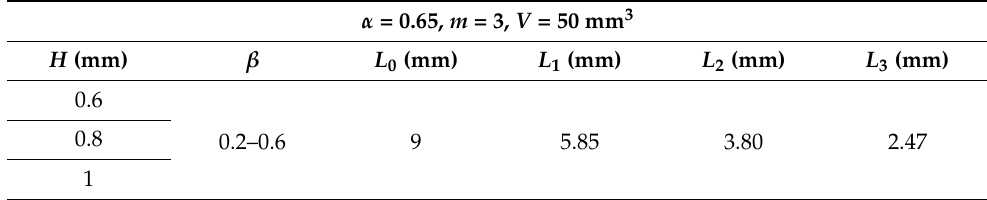
Table 4. Geometric parameters of branched HCM with different H .